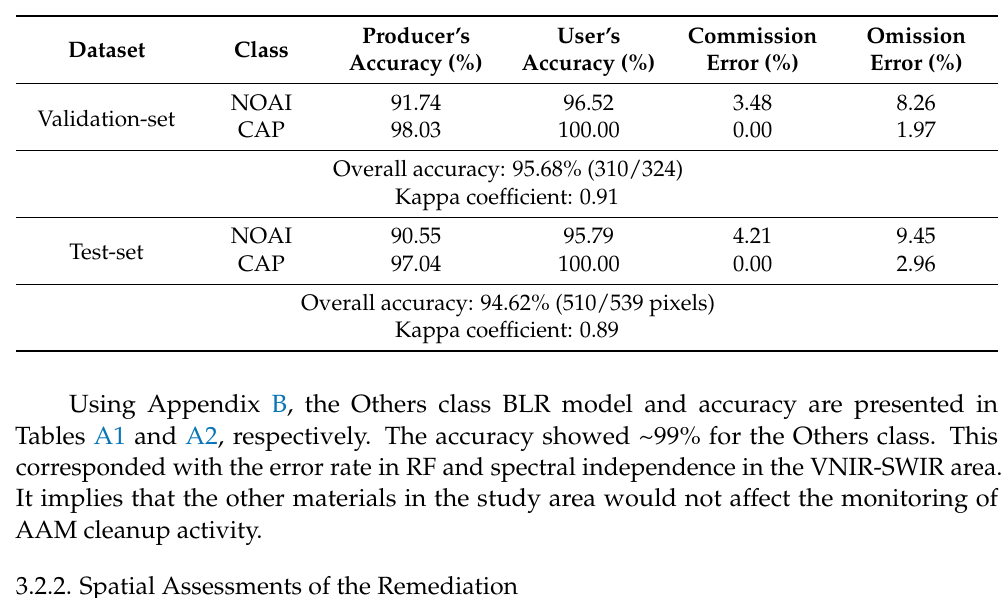
Table 7. Confusion matrix of the validation and test dataset for NOAI and CAP classification models applied to 2018 AVIRIS.